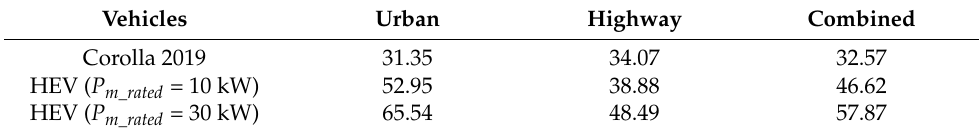
Table 6. Maximum MPGs of Corolla-based vehicles.